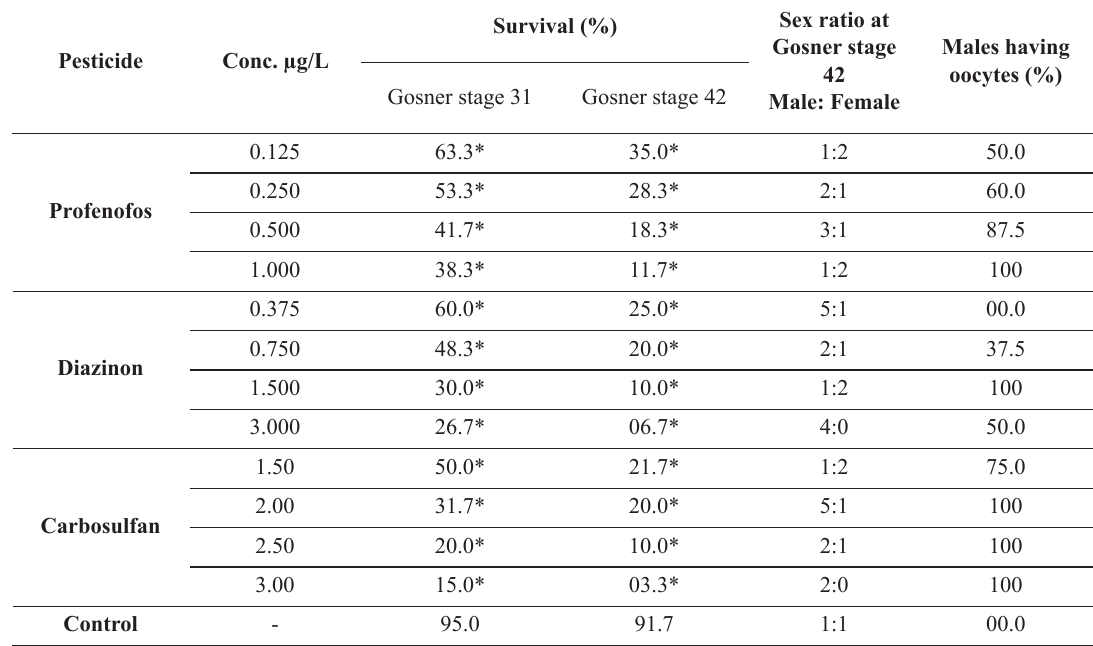
Table 4: Percentage survival, sex ratio and percentage of males developed testicular oocytes of Polypedates cruciger exposed to ecologically relevant concentrations of the three chemicals and the control ( n =